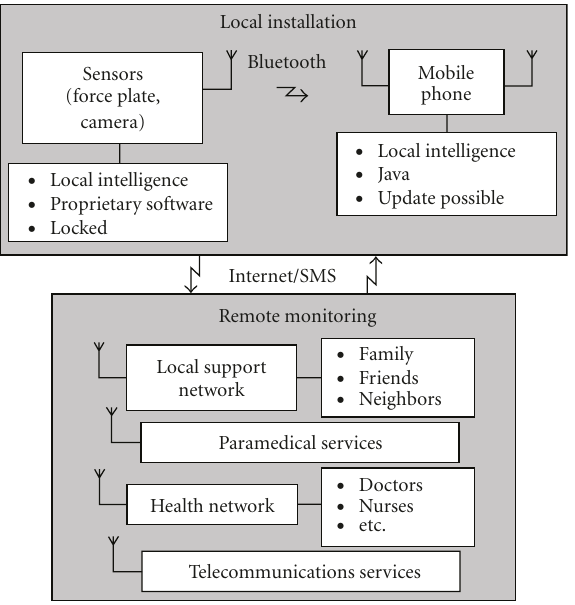
Figure 13: Schematic diagram of a remote monitoring system for balance